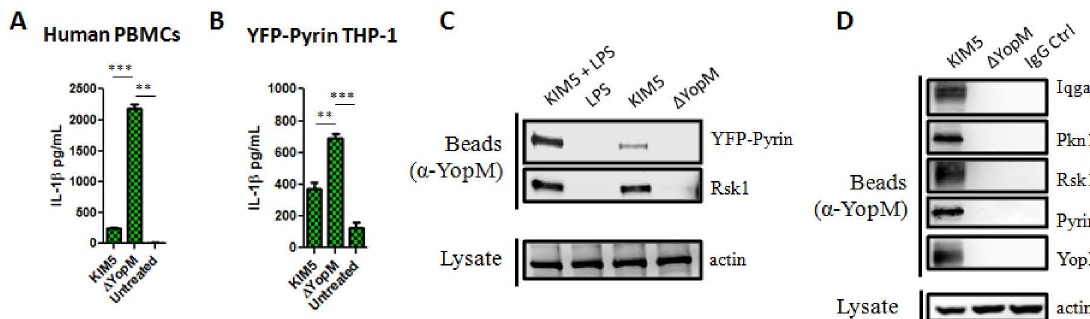
Fig 5. YopM maintains an inhibitory phenotype in human PBMCs, and in a human THP-1 cell line overexpressing YFP-Pyrin. Co-IP pulldownin these cells as well as mouse BMDMs indicateYopM interaction with Pyrin, Rsk1, Pkn1, and Iqgap1. A) PBMCs were isolated from healthy humandonor blood and infected at MOI 10 with indicated Y . pestis strains without priming. At 6 hours p.i. supernatantwas collectedfor IL-1 β detectionby ELISA. B) CulturedYFP-Pyrin THP-1 cells were differentiatedwith 100nMVitamin D3 for 48–72 hours, and infected with indicated Y . pestis strains at MOI 10. Shown is IL-1 β assayed from supernatantsby ELISA at 6 hrs p.i. Figures are representative of three or more experiments. Shown is mean